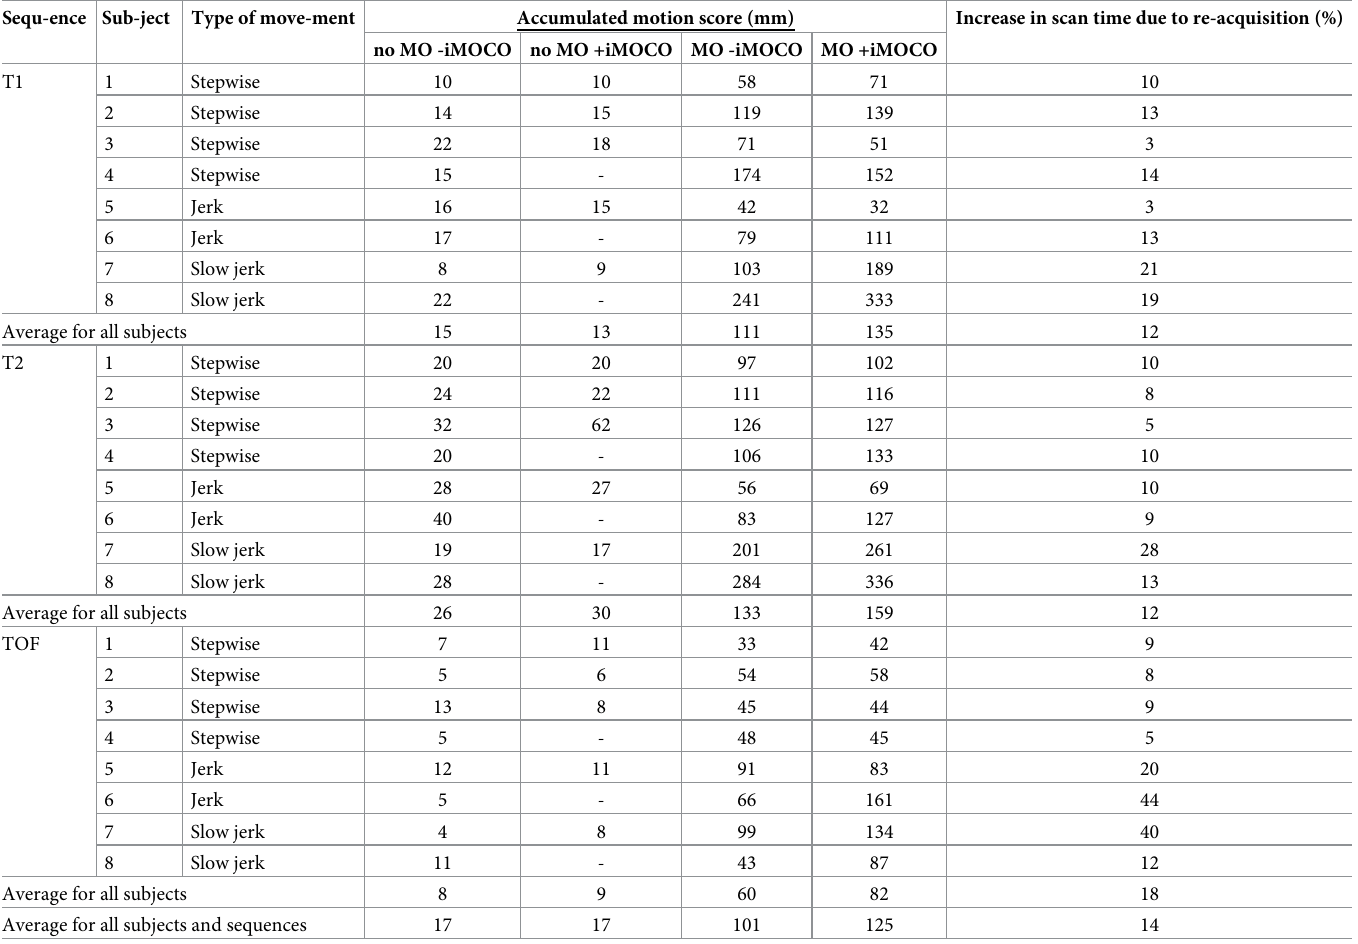
Table 4. Accumulated motion scores during all scans, and the relative increase in scan time for the scans with motion (MO) and correction (iMOCO). Sequ-ence Sub-ject Type of